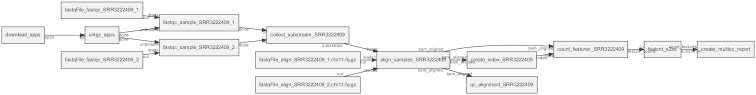
Directed graph of workflow processes in the RNA-Seq Pre-processing workflow, plotted with SciPipe’s workflow plotting function. Nodes represent processes, while edges represent data dependencies. The labels on the edge heads and tails represent ports.